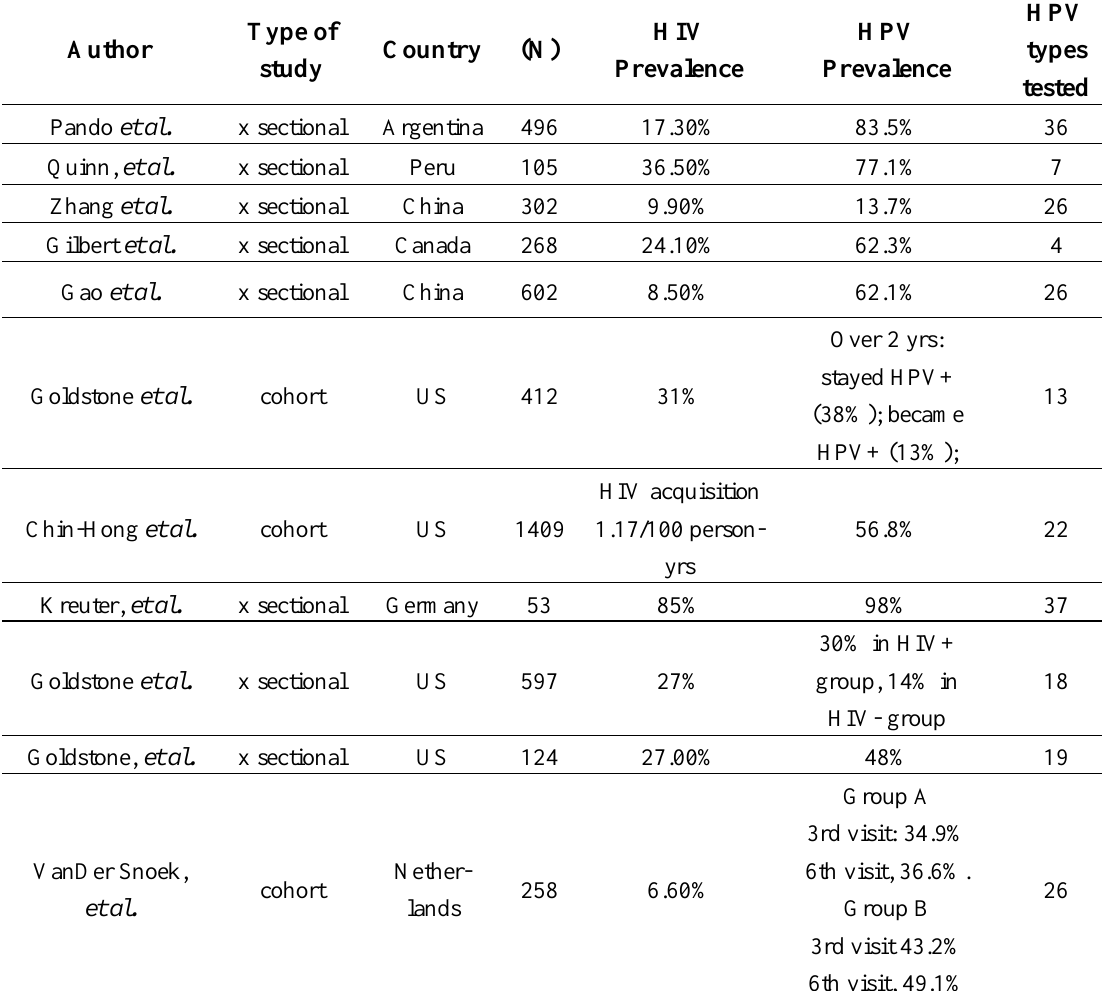
Table 1. Select characteristics of studies identified in the literature review,